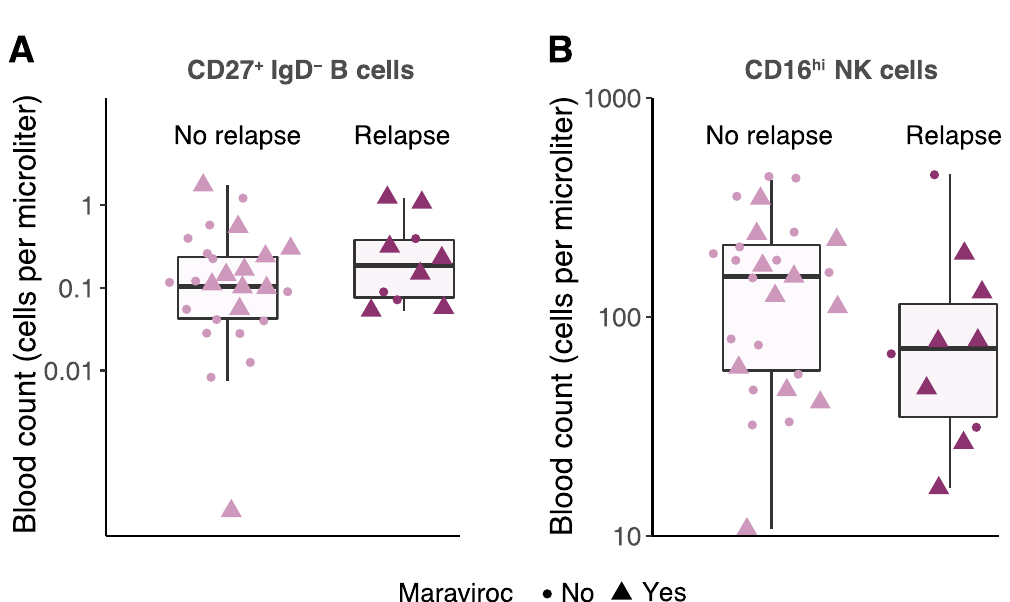
Figure 3. Blood counts (cells/ µ l) of CD27 + IgD − memory B cells ( A ) and CD16 hi NK cells ( B ) in patients, stratified by relapse and maraviroc